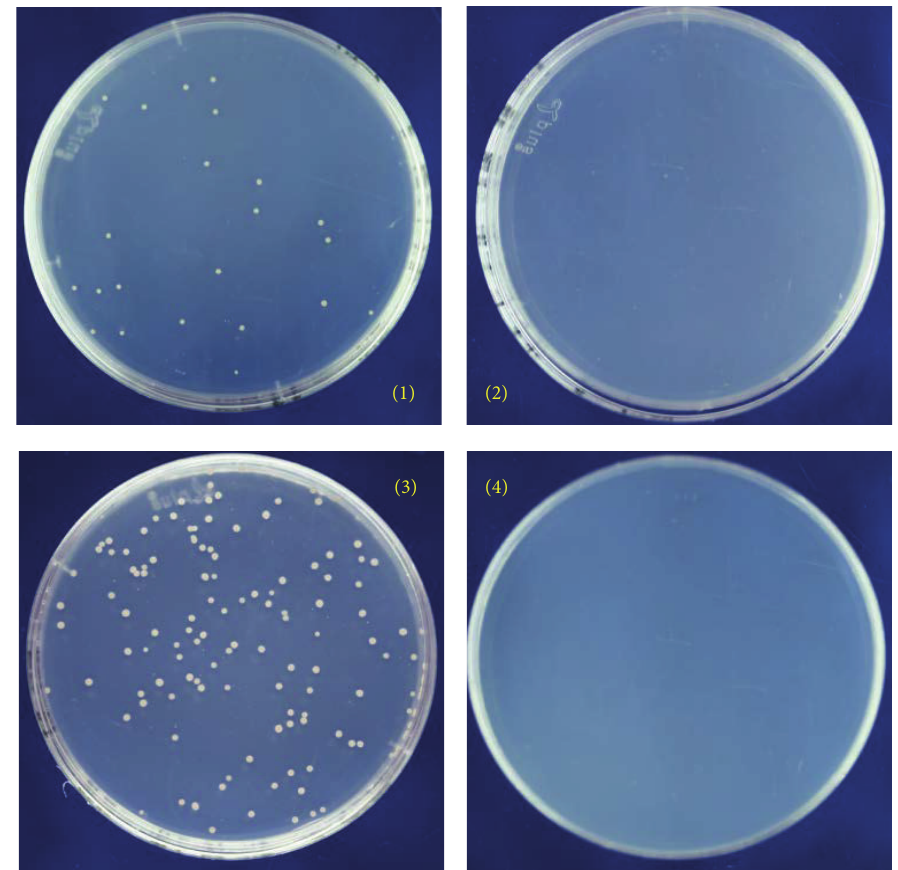
Figure 3: Results of the transformation of J7-2-1 and J7-2-26 with J7-2 genome. The wild type Natrinema sp. J7-2 total genomic DNA was isolated and then transformed into two auxotrophic mutants, J7-2-1 and J7-2-26. The transformation mixture was spread on the MM plates and cultivated at 42 ∘ C for 15 days. The detailed transformation process was described in Materials and Methods. (1) J7-2-1 transformed with J7-2 genome. (2) Negative control, J7-2-1 transformed with salt solution without DNA. (3) J7-2-26 transformed with J7-2 genome. (4) Negative control, J7-2-26 transformed with salt solution without